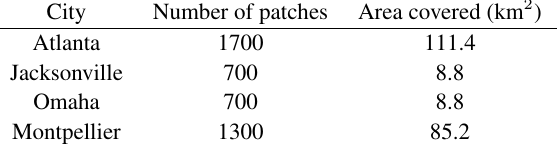
Table 1. Quantity of data by city